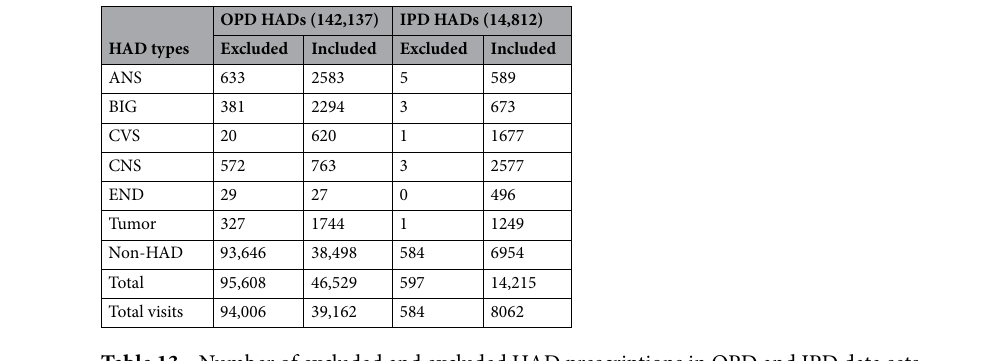
Table 13. Number of excluded and excluded HAD prescriptions in OPD and IPD data